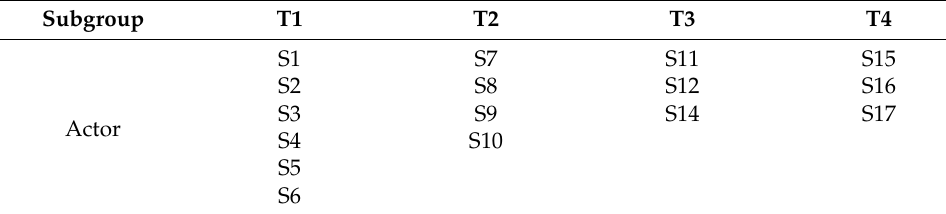
Table 5. Construction project subgroup